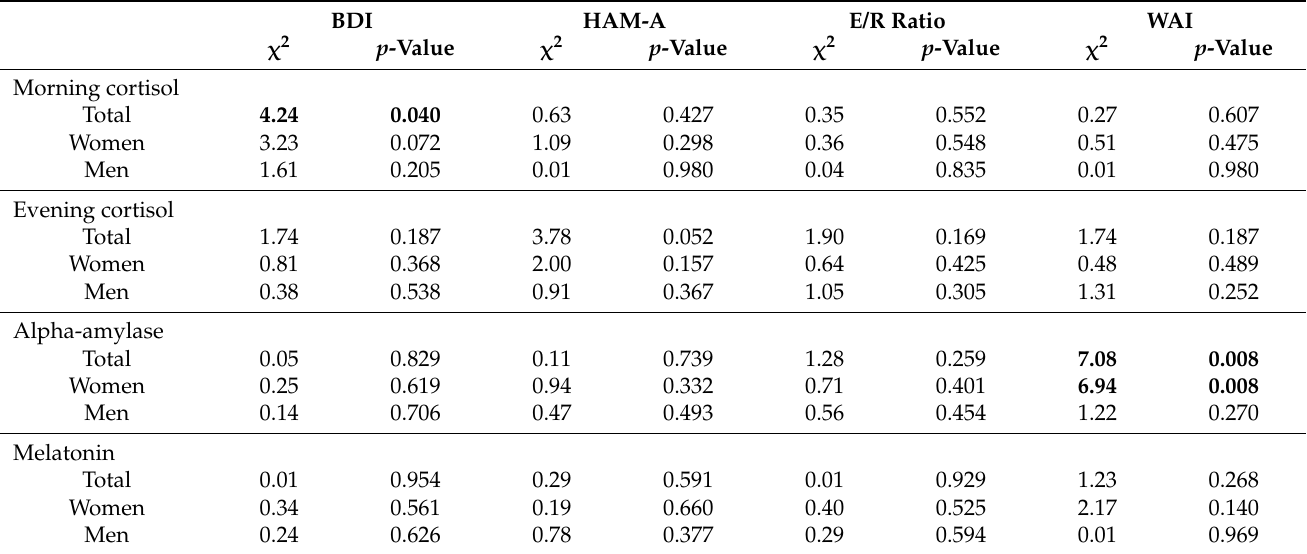
Table 5. Contingency analyses between work-related stress scales and salivary